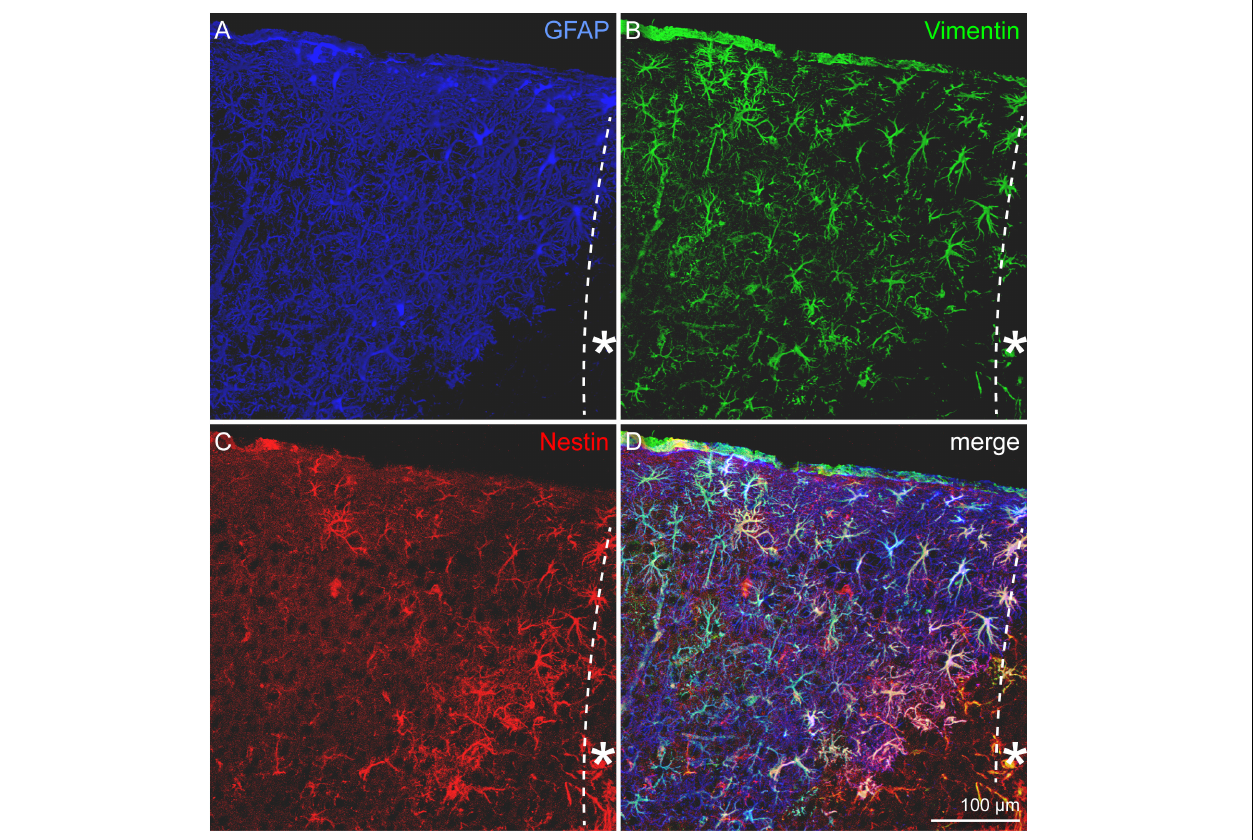
FIGURE 3 | Astrocytic subpopulations in the lesioned cortex, 3 dpl. (A) GFAP-positive, reactive astrocytes appeared in high numbers in the penumbra. GFAP was broadly upregulated, whereas vimentin (B) and most strikingly nestin (C) were restricted to cells near the lesion core. Nearly all of the vimentin- and nestin-expressing cells were also positive for GFAP (D) . Asterisk: direction toward the lesion core; scale bar: 100 µ m.